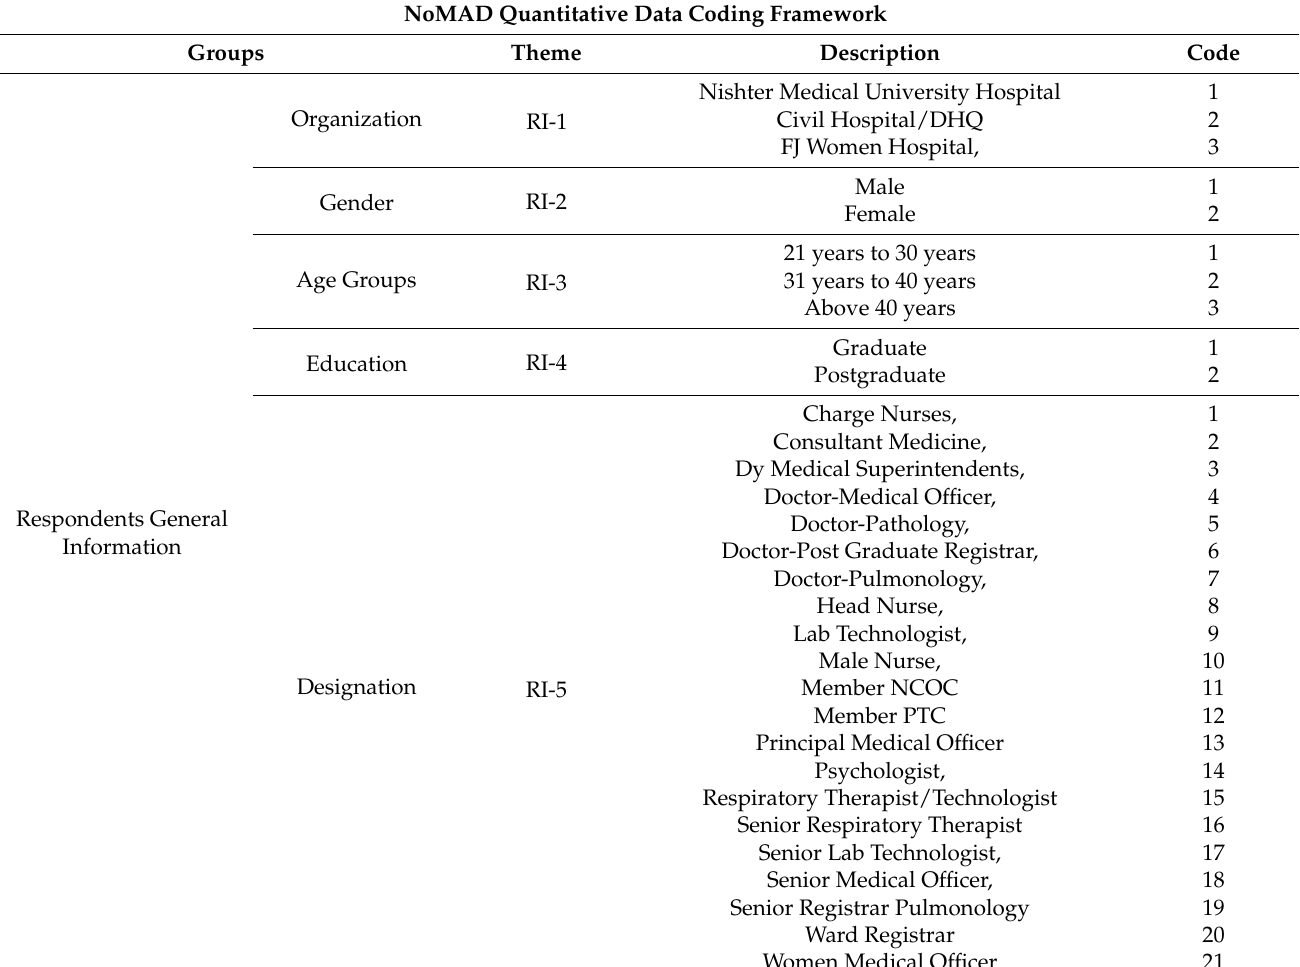
Table A2. Coding Framework for Quantitative Data